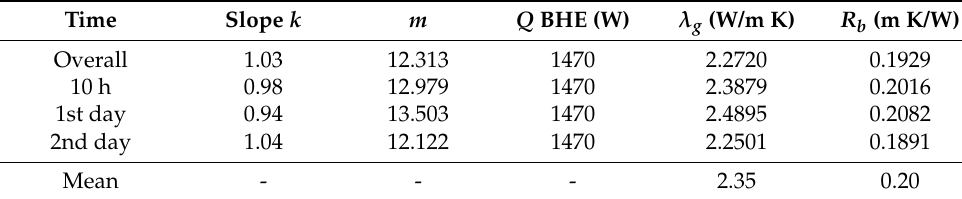
Figure 9. Regression line with different time intervals, excluding the first 10 h, 24 h, and 48 h. Table 3. Results of the analytical model.